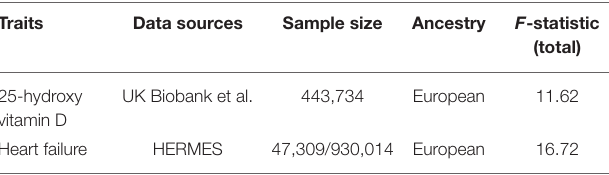
TABLE 1 | Characteristics of data sources and strength of IVs used in the Mendelian randomization